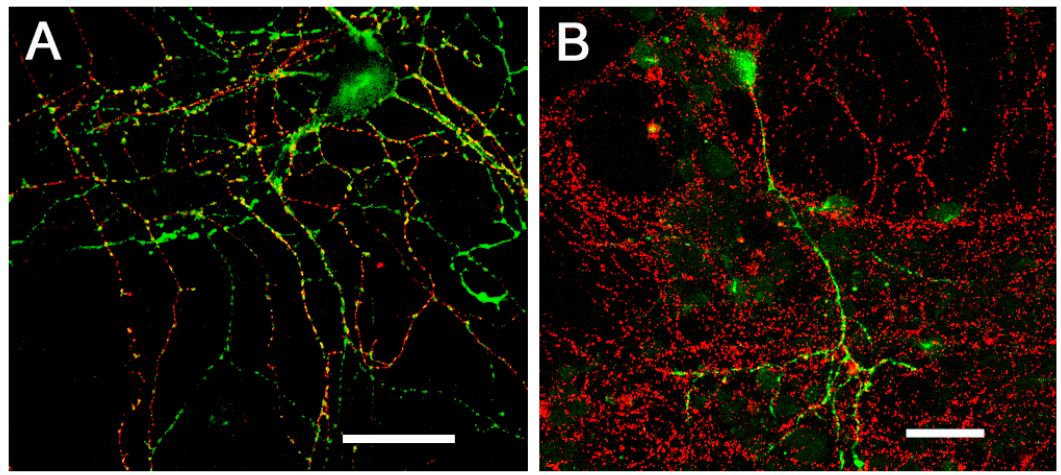
FIGURE 1 . A comparison of cell surface CB 1 receptor immunoreactivity in cultured hippocampal neurons and cerebellar granule cells. (A,B) dual labeling of surface CB 1 receptors (red) and glutamate decarboxylase (GAD), a marker for inhibitory terminals/neurons (green). The extent of colocalization is shown by the yellow regions of overlap. Both cultures express strong, punctate CB 1 receptor immunoreactivity on fine fibers. Note the marked correspondence between CB 1 receptor label and clusters of GAD immunoreactivity in the cultured hippocampal neurons (A), but not in the cerebellar granule cells (B). An antibody raised against the N-terminus of the cloned rat CB 1 receptor was used to detect cell surface immunoreactivity. Scale bars, 20 (cid:181)